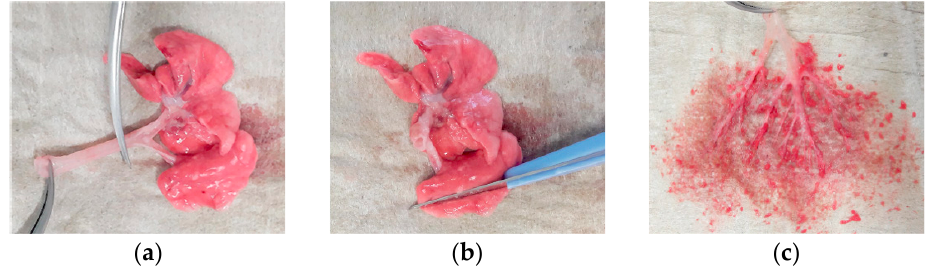
Figure 1. Preparation of tissue samples. ( a ) Sampling of the trachea from the intact lungs; ( b ) cutting a slice from the lateral part of the left lung; ( c ) bronchial sample after removal of the surrounding parenchyma.